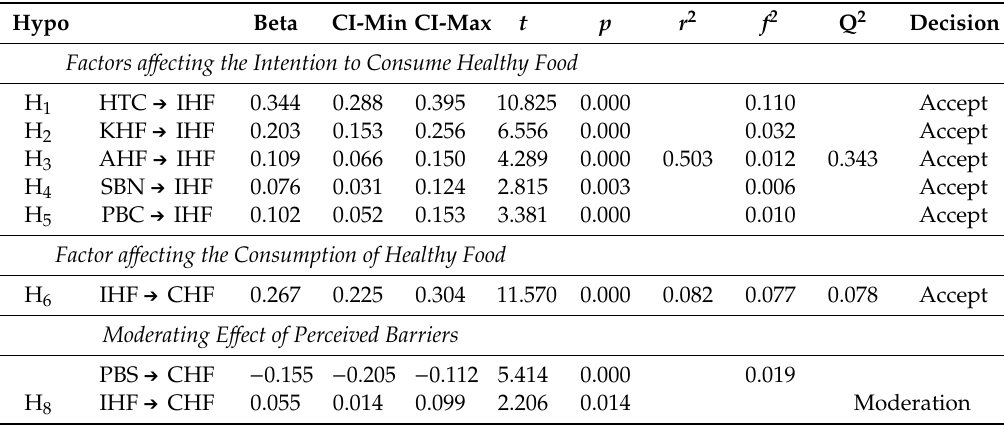
Table 5. Path coe ffi